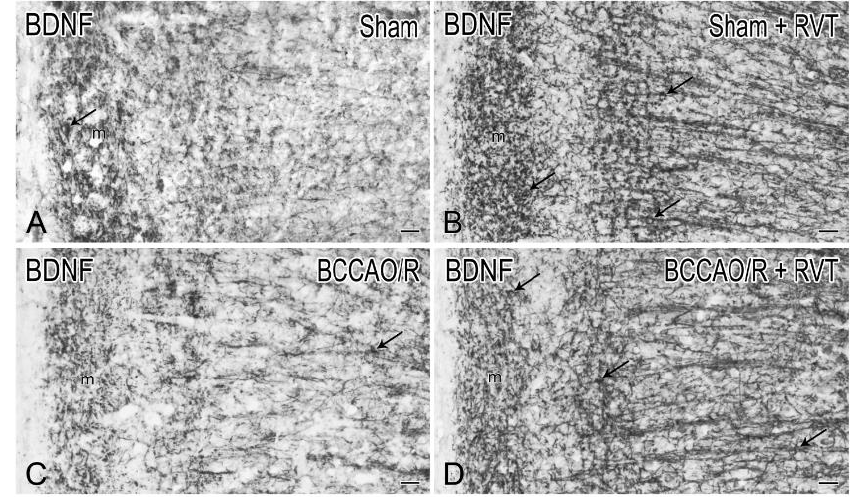
Figure 2. Brain-derived neurotrophic factor (BDNF)-like immunoreactivity in coronal sections of frontal cortex of sham-operated and bilateral common carotid artery occlusion followed by reperfusion (BCCAO/R) rats, pre-treated with either the vehicle alone ( A , C ) or with resveratrol (RVT) ( B , D ). Positive neuronal processes, punctate elements, and neuronal perikarya are distributed across the whole thickness of the cortex. Arrows point to immunostained neuronal perikarya. Panels are representative of observations carried out in 6 rats for each group. m, molecular layer. Scale bars: 25 µ